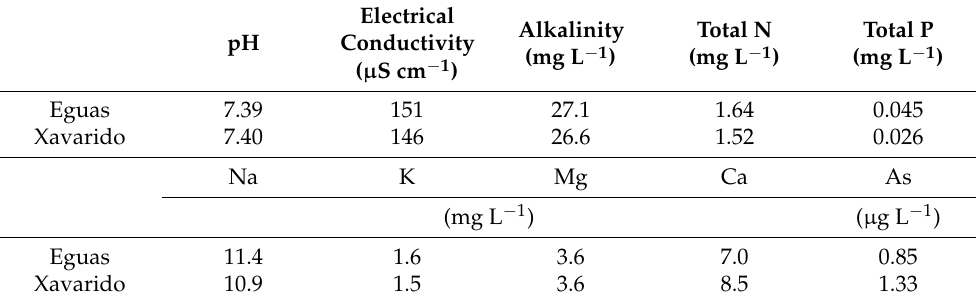
Table 1. Chemical characteristics of the Anll ó ns River water used for the experiments.